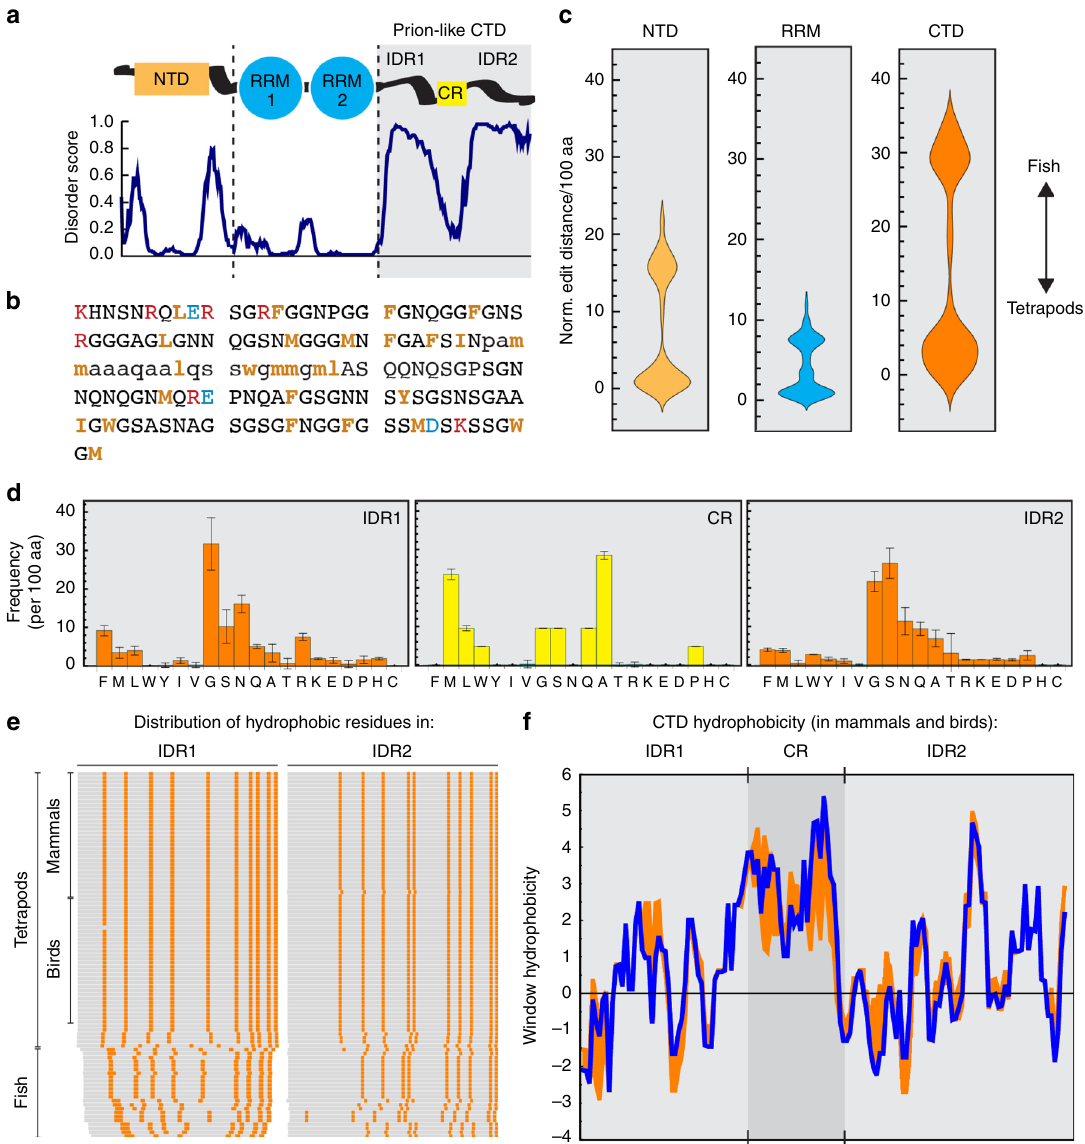
Fig. 1 Identi fi cation of conserved sequence features in the TDP43 CTD. a Disordered regions in TDP43. The RNA-binding protein TDP43 is comprised of a folded N-terminal domain (NTD), two folded RNA-recognition motifs (RRM 1&2) and disorder-containing C-terminal domain (CTD) featuring a highly conserved region (CR). Disorder predictions are based on DisoPred (bioinf.cs.ucl.ac.uk/psipred) analysis of human TDP43 (UniProtKB Q13148). b Primary amino-acid sequence of the human TDP43 CTD. Disordered regions are in capital and the CR in lower-case letters. Hydrophobic motifs are highlighted in bold orange, negatively-charged residues in blue and positively-charged residues in red. c Violin plots of the sequence divergence (represented as normalized Levenshtein distance per 100 aa) between the NTDs, RRMs, and CTDs of 93 vertebrate TDP43 homologs. The plots show two clusters each, corresponding to fi sh and tetrapod TDP43 homologs. d Amino-acid composition of the intrinsically disordered regions (IDRs) and conserved regions (CRs) that comprise the TDP43 CTD. Plotted are mean amino-acid frequencies per 100 residues ± standard deviation ( n = 93). e Distribution of hydrophobic residues (V, L, I, M, F, Y, W; shown in orange) in the IDRs of 93 vertebrate TDP43 homologs (outlined in gray). Each row represents one homolog. f Comparison of the hydrophobicity distribution across mammalian and avian TDP43 CTDs. Hydrophobicity was calculated in a sliding window of fi ve amino acids on the scale of Fauchère and Pliska 24 (blue trace: human CTD; orange area: deviation amongst CTD